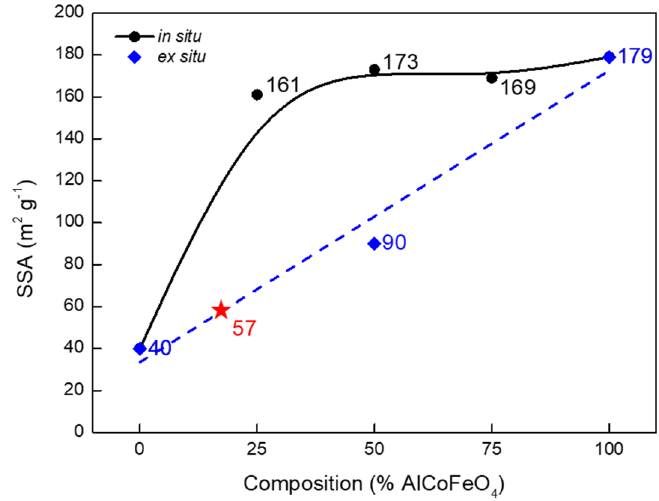
Figure 3. Variation in BET surface area of the FLG-CNT hybrids formed from a mixture of catalysts (in situ) as a function of added AlCoFeO 4 (CNT catalyst). The dashed line (in blue) is obtained by measuring the BET surface area of physical mixtures of CNTs and FLG (ex situ). The star (in red) represents the BET surface area of the hybrid prepared from the single catalyst.